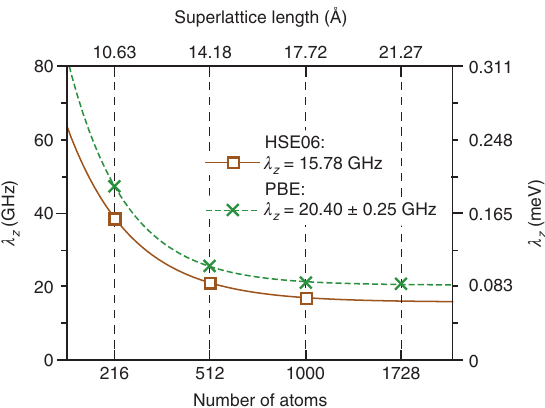
Figure 10: Convergence of the axial spin-orbit coupling parameter λ in the excited state of the NV center [105]. Horizontal axes shows the supercell size and the number of carbon atoms in the defect free supercells within Γ -point sampling. DFT PBE calculations prove the exponential decay of the value that can be used to fit the converged value for DFT HSE06